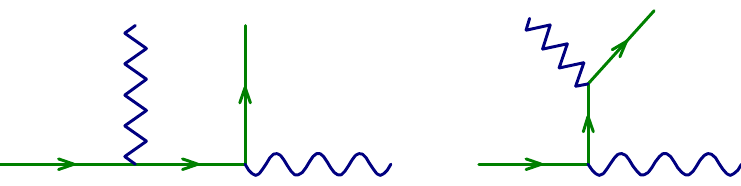
Figure 6 . The amplitudes for the Born contribution in the qγ → Zq process. The zigzag line represents the Z boson, while the wavy line represents the incoming photon.